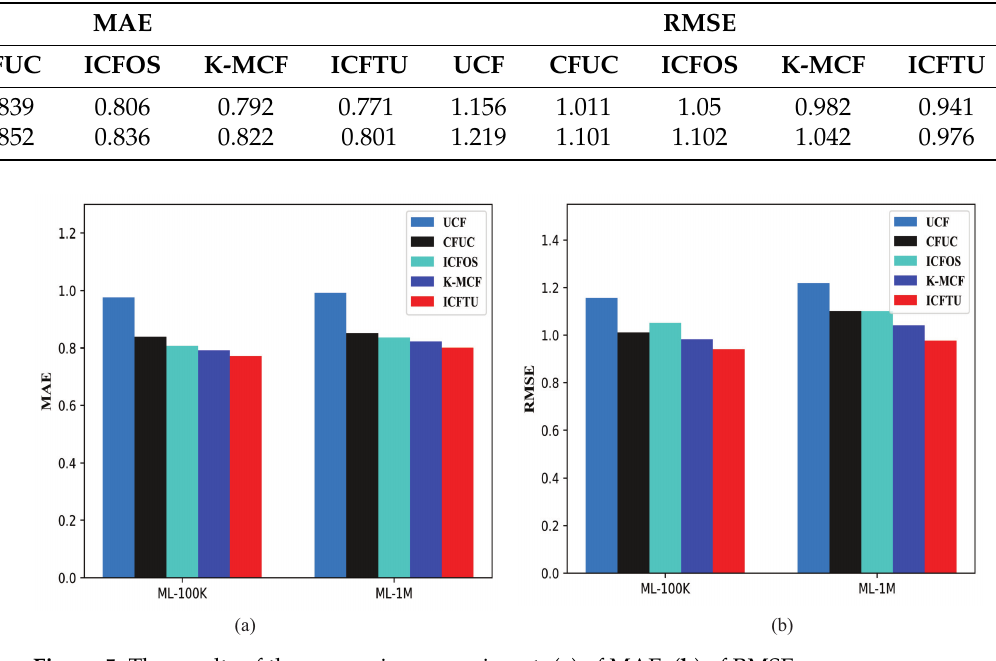
Figure 5. The results of the comparison experiment: ( a ) of MAE; ( b ) of